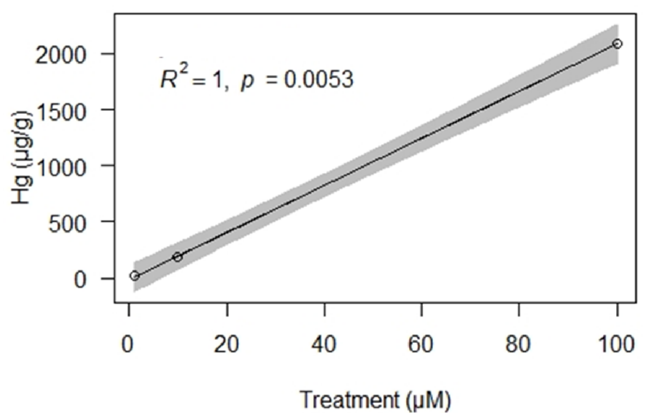
Figure 2. Linear regression between the content of Hg in the treatment solutions and in the lichen Evernia prunastri . Gray area = 95% confidence interval.